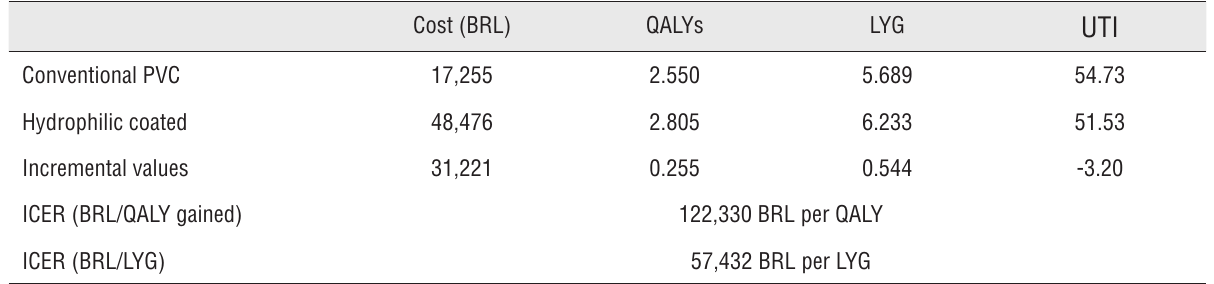
Table 3 - Cost-effectiveness results of primary analysis (all adverse